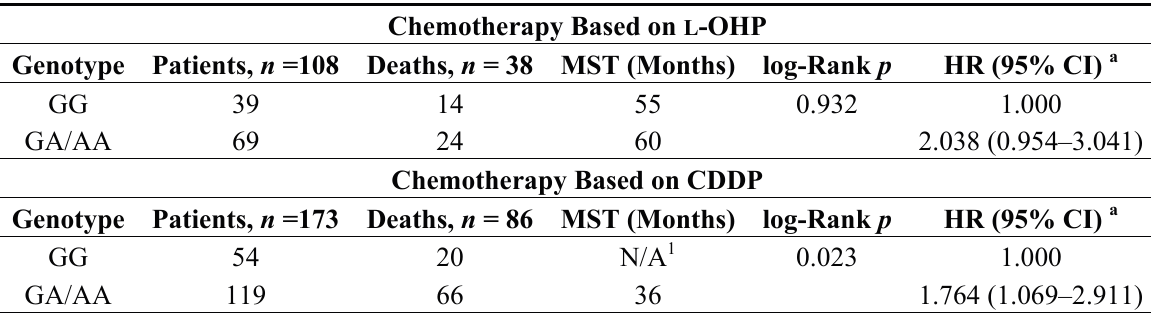
Table 4. Association between the dominant model of rs10505477 and overall survival of gastric cancer among chemotherapy regimen subgroup.